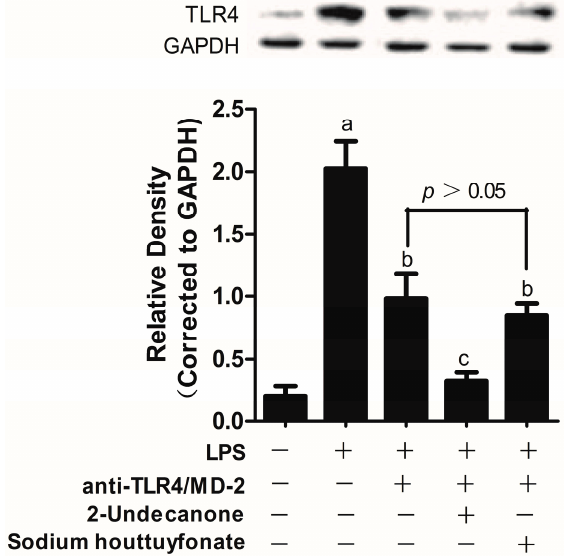
Figure 3. The effects of sodium houttuyfonate and 2-undecanone on the expressions of TLR4 in LPS-induced RAW264.7 cells. Upper panel: Western blots for TLR4 protein expression, protein levels of TLR4 were normalized to GAPDH loading control, the picture is of a single representative experiment; Bottom panel: TLR4 expression in RAW264.7 cells stimulated with LPS and LPS plus anti-TLR4/MD-2 or the two components. The cells were pretreated with anti-TLR4/MD-2 (10 μ g/mL) or plus the two compounds (10 μ g/mL)